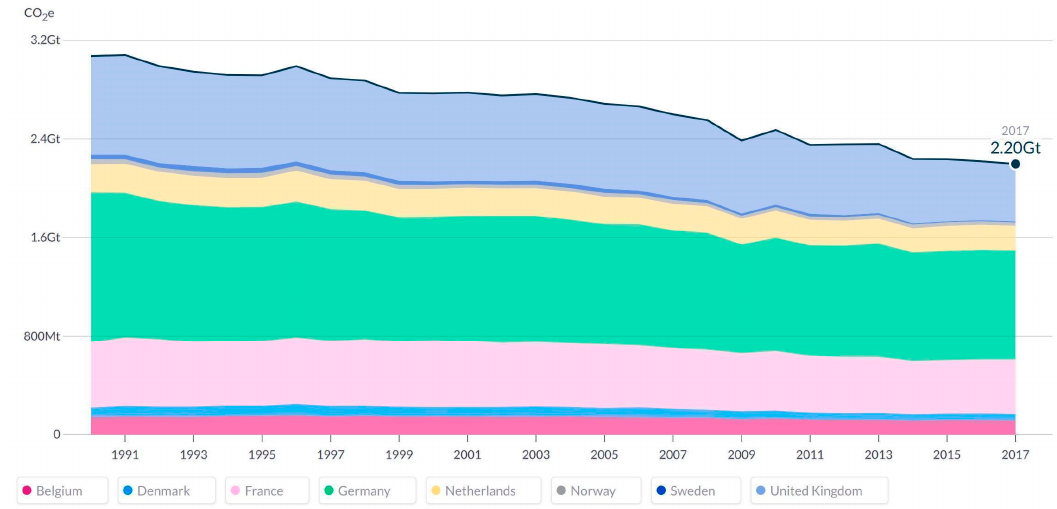
Figure 2. Historical greenhouse gas (GHG) emissions by the North Sea (NS) countries (1990–2017). Adapted from [7,8].